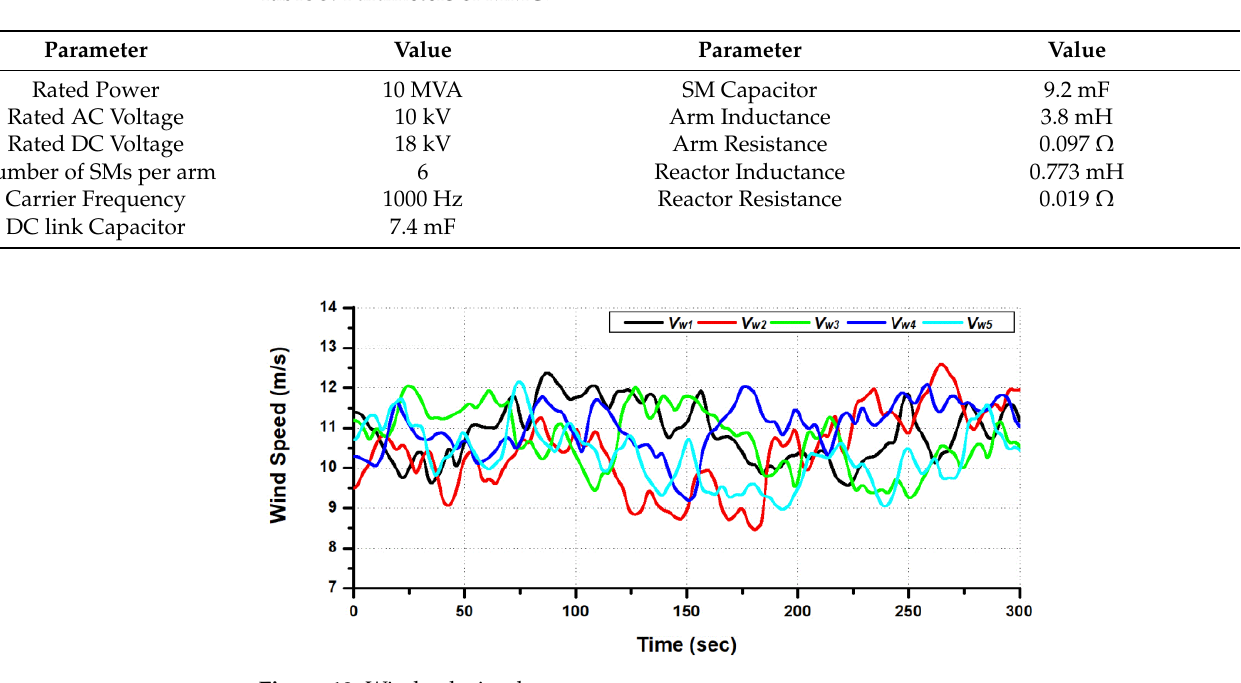
( f ) Figure 19. Dynamic Performances of WTG1 under steady-state condition: ( a ) Rotor speed response; ( b ) Voltage profiles at the terminal of the stator winding; ( c ) Active and reactive power output of the PMSG; ( d ) DC link circuit voltage profile; ( e) Active and reactive power output of grid-side MMC; ( f ) Voltage profile at Bus BG1.